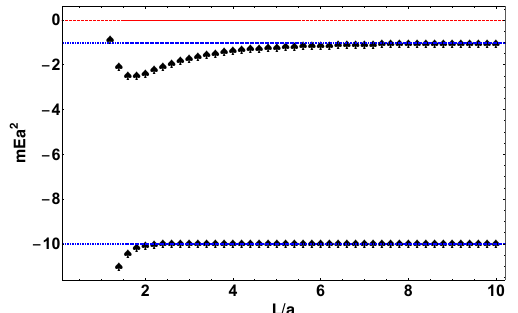
Figure 9: The two Efimov states in a finite